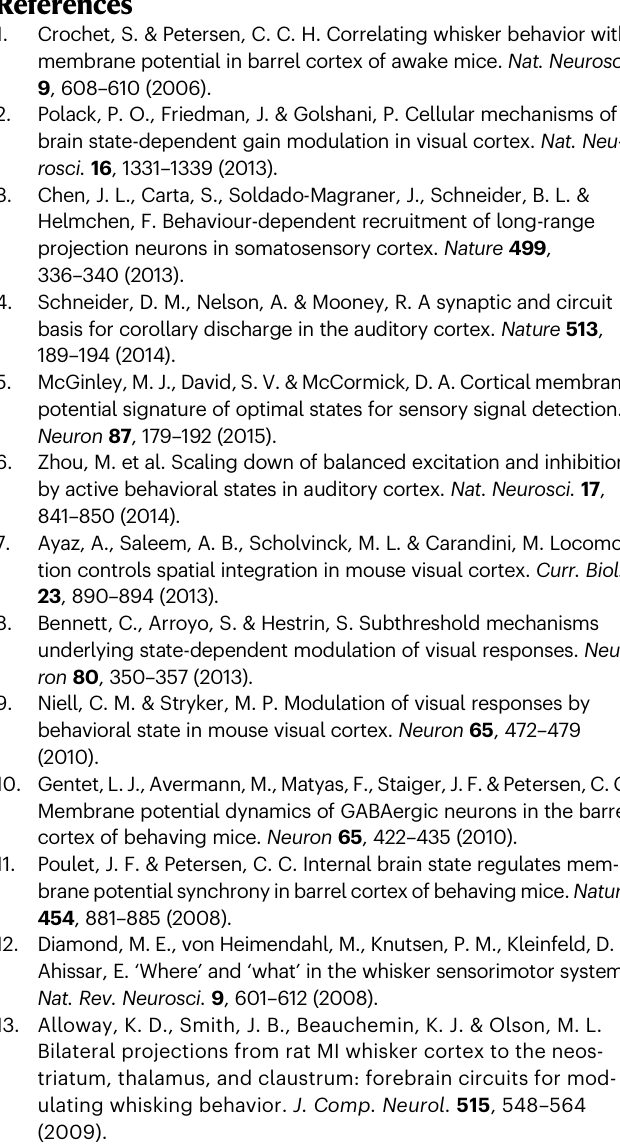
test, * P =0.01; dMSN control I=4.01±0.87mV; dMSN 6-OHDA I=1.64±0.40mV, two-sidedunpairedttest,* P =0.02)withoutaffectingonsetdelayorAUC( n =13)in the dMSNs of 6-OHDA lesioned mice compared to dMSNs in control mice ( n =13). d Grand average of the late component of iMSNs in control (left) and 6-OHDA (right) lesioned mice to contralateral (red) and ipsilateral (light red) whisker sti- mulation. The light red rectangle indicates the late component of the response to sensory stimulation. The gray bar indicates the moment the stimulation was delivered. e No differences in response amplitude, onset delay or AUC of iMSNs between contralateral (C) and ipsilateral (I) stimulations in control ( n =12) or 6-OHDA lesioned mice ( n =13). For c , e each gray line represents the data from a single cell and error bars indicate mean±SEM. Complete summary of values is shown in Supplementary Table2. Source data are provided as a Source Data fi